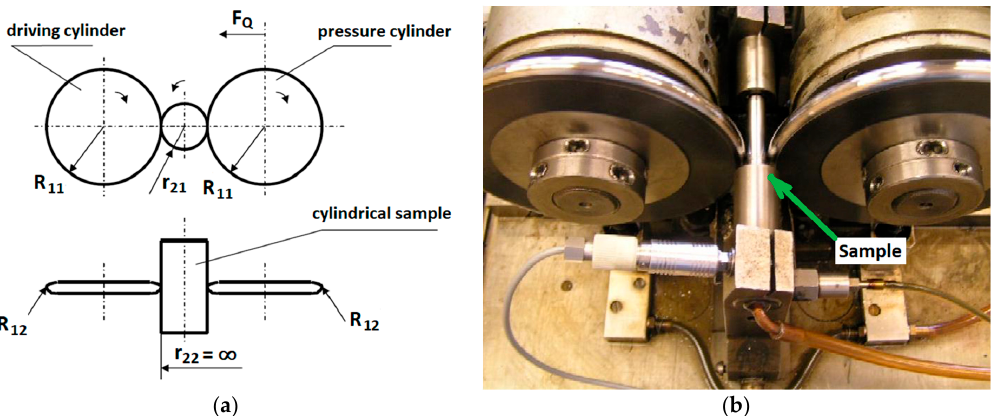
Figure 1. Fatigue contact testing ( a ) scheme of the friction element arrangement during the test on R-MAT. ( b ) An evaluated sample in R-MAT.